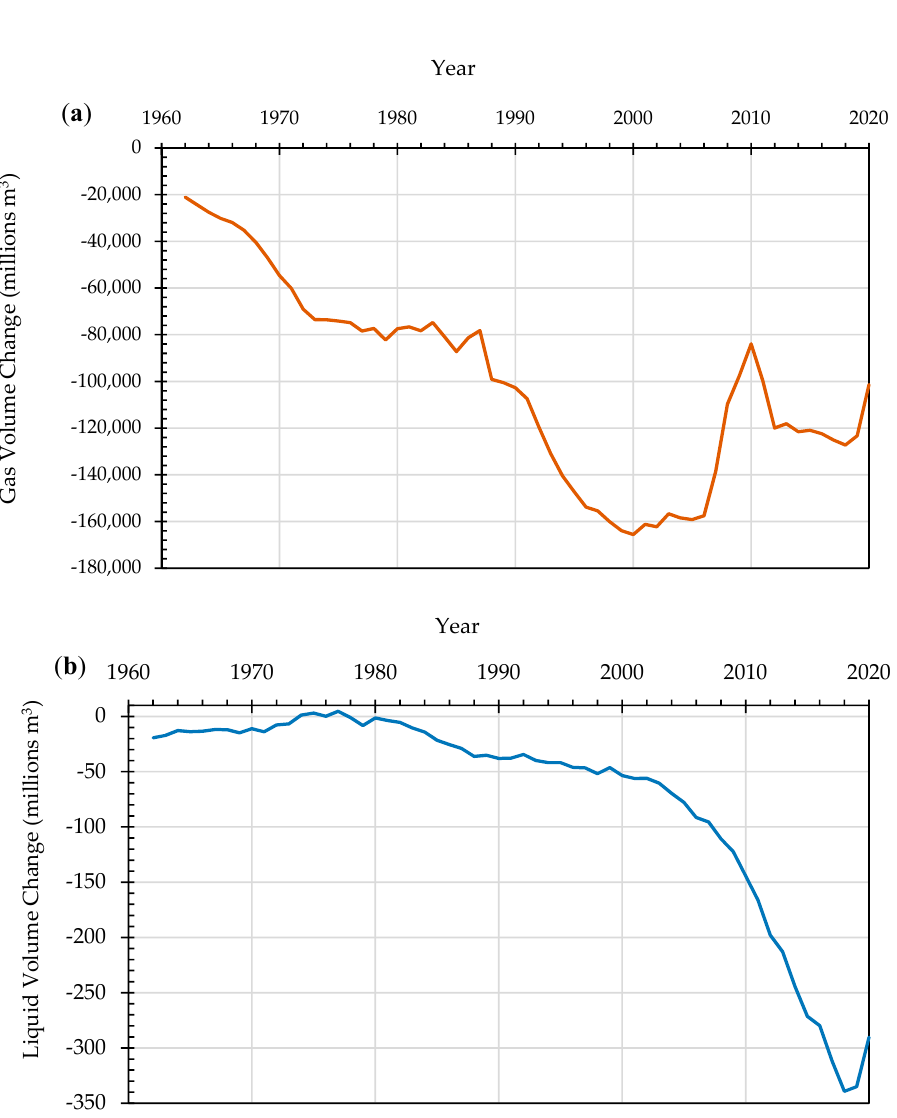
Figure 2. Calculated net stock tank (a) gas balance (gas injected – gas produced) trend and (b) liquid balance (liquid injected – liquid produced) trend in the Alberta Basin for the period 1960 – 2020. Source data extracted from geoLOGIC Systems databases ©